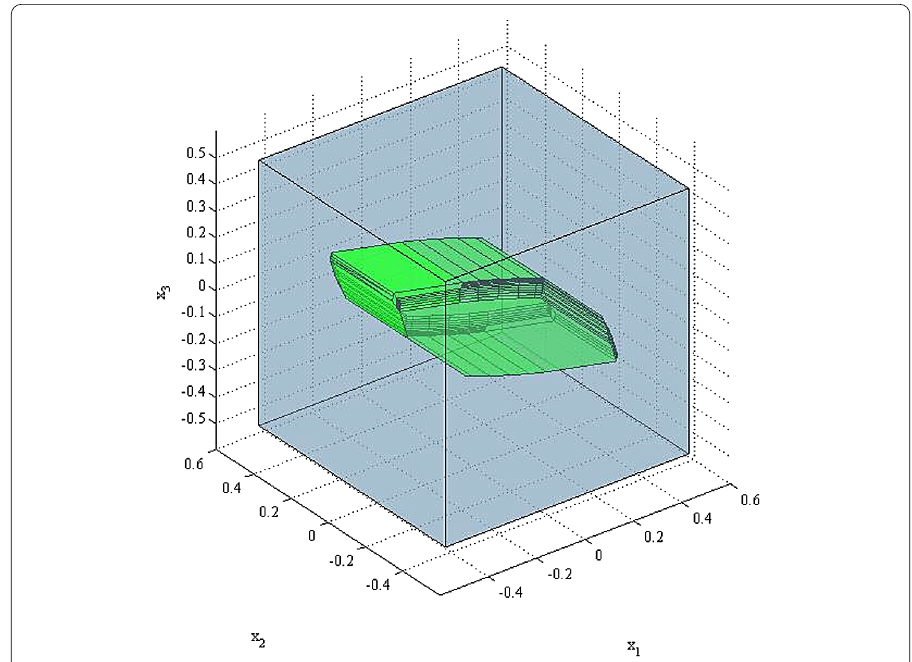
Figure 3 Viability constraint (5.7) (grey) and the corresponding viability kernel (green) for (5.5) by using Algorithm